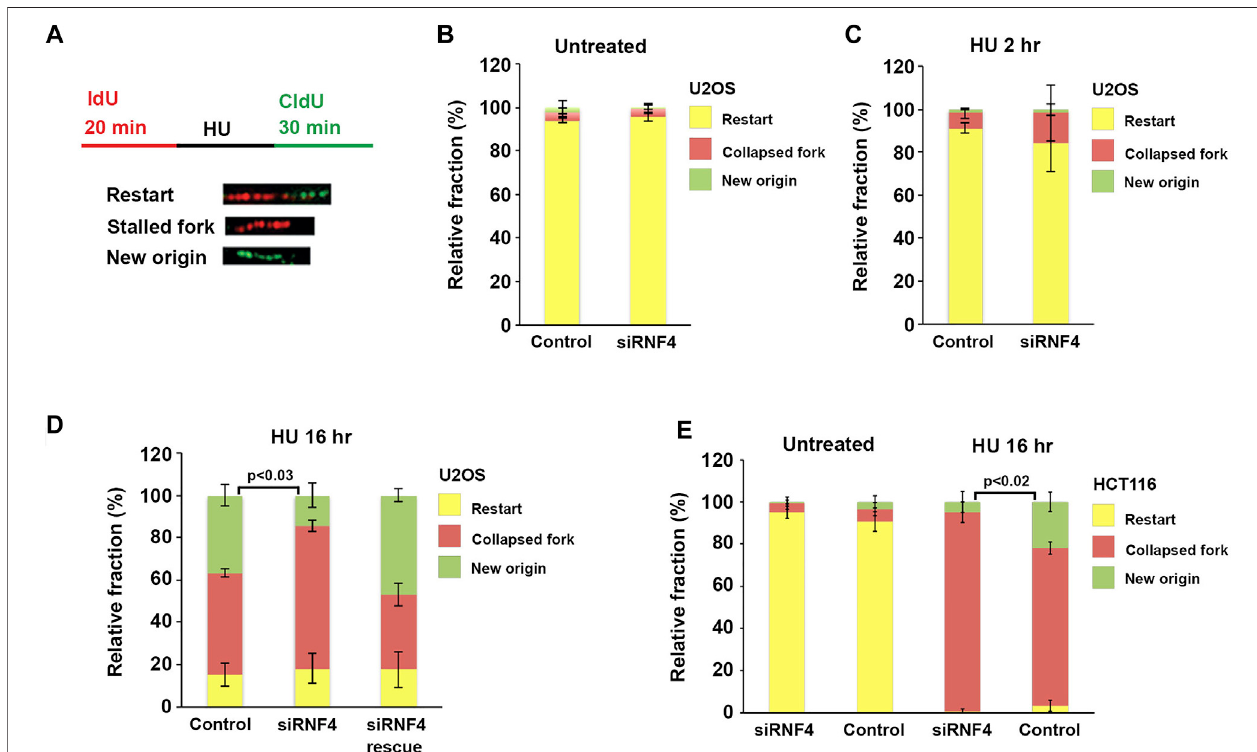
FIGURE 4 | RNF4 depletion reduced dormant origin activation following prolonged replication stress. (A) Schematic representation of the dual labeling DNA fi ber assay and possible outcomes. (B) Quantitative analysis of replication restart in control and RNF4-depleted U2OS cells in the absence of HU. Results from three independent experiments with standard deviations are shown. (C) Quantitative analysis of replication restart in control and RNF4-depleted U2OS cells following release from2-htreatmentswith2 mMHU.Resultsfromthreeindependentexperimentswithstandarddeviationsareshown. (D) Quantitativeanalysisofreplicationrestart afterreleasefrom16-htreatmentswith2 mMHU.CellstransfectedwithRNF4-speci fi csiRNAstogetherwithansiRNA-resistantRNF4cDNAshowedcomplementation. Results from three independent experiments with standard deviations are